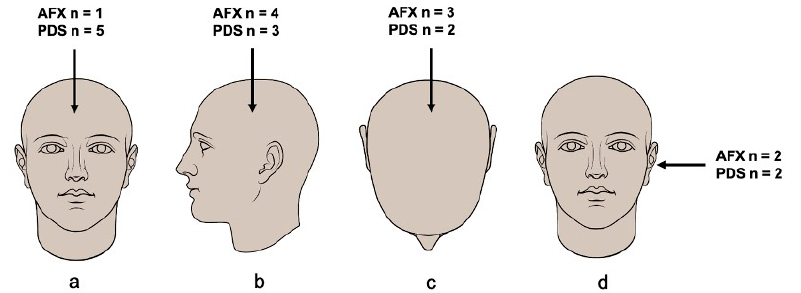
Figure 3. Primary tumor sites of AFX and PDS. ( a ) frontal area, ( b ) parietal area, ( c ) vertex, ( d ) auricular area. One primary PDS tumor was located at the lower leg is not represented in this figure.